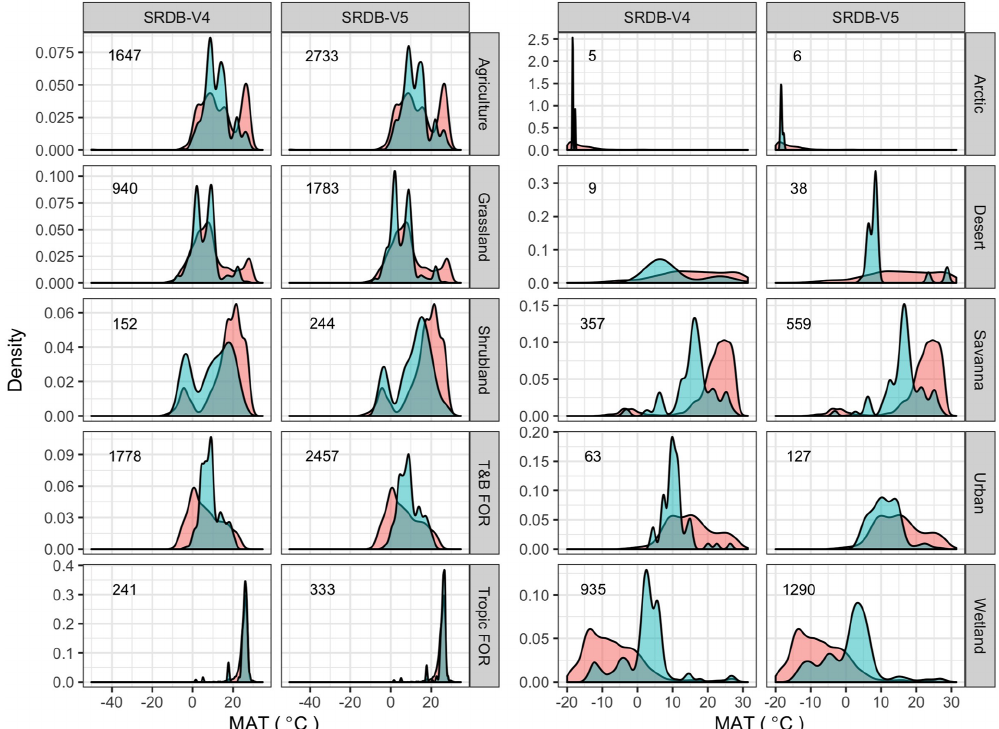
Figure 3. Comparison of mean annual temperature (MAT; ◦ C) around the globe (in red) vs. MAT from the sites in the global soil respiration database (SRDB; in teal) by the vegetation types. SRDB-V4 represents the older SRDB released in 2018, and SRDB-V5 represents the newest SRDB published in 2020. Data from SRDB cover 10 vegetation types (agriculture, arctic, desert, tropical forest (tropic FOR), temperate and boreal forest (T&B FOR), grassland, savanna, shrubland, urban, and wetland). Comparing the fourth version (SRDB-V4) to the newest version (SRDB-V5), MAT values of agriculture, forest, and grassland sites generally well represent the global MAT; in contrast, MAT from shrubland sites in the database did not well represent global means in the older SRDB-V4, but their representation significantly improved in the newest SRDB-V5; for other vegetation types (arctic, desert, savanna, urban, and wetland (including peatland) in the right panel), the MAT of the database sites does not well represent the global MAT distribution. Note that the barren region was masked using MODIS land cover data. The number within each panel represents the number of records for each vegetation